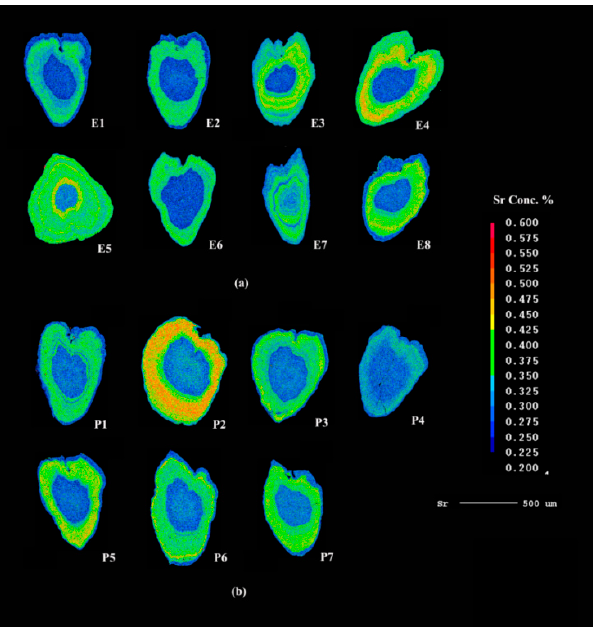
Figure 7. Two-dimensional imaging using X-ray electron microprobe analysis of the Sr concentrations in the sagittal plane of the otoliths of individual Coilia nasus from Yangtze River estuary ( a ) and Poyang Lake ( b ), China. The values corresponding to Sr concentrations are represented by 16 colors from red (highest) through yellow and green, to blue (lowest).